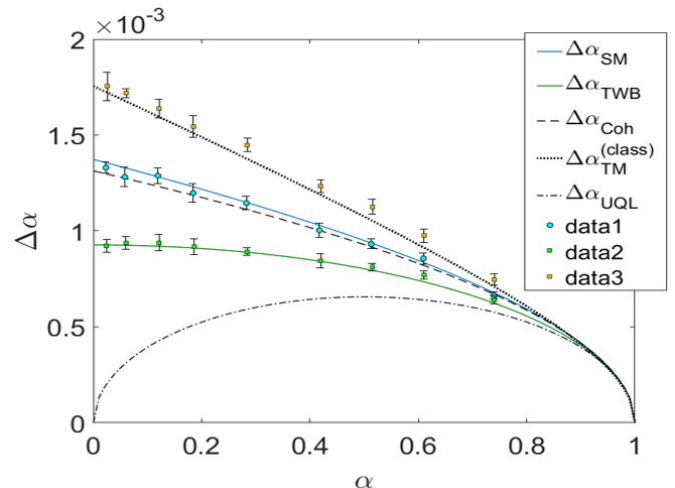
Figure 2. Uncertainty on α varying the mean absorption α . A quantum enhancement of ∼ 40% for α ∼ 2% is demonstrated. Description of the different estimators and theoretical limits is presented in the